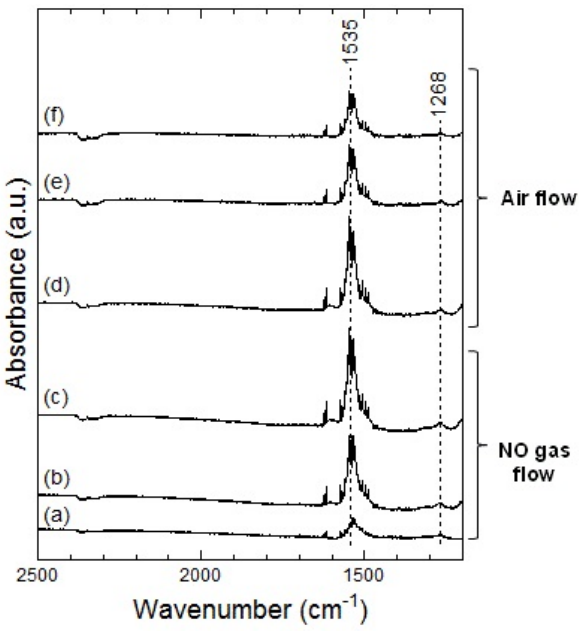
Figure 14. DRIFT spectra of Co 1 ppm of NO in air for ( a ) 2 min, ( b ) 20 min, and ( c ) 50 min. After NO exposure,